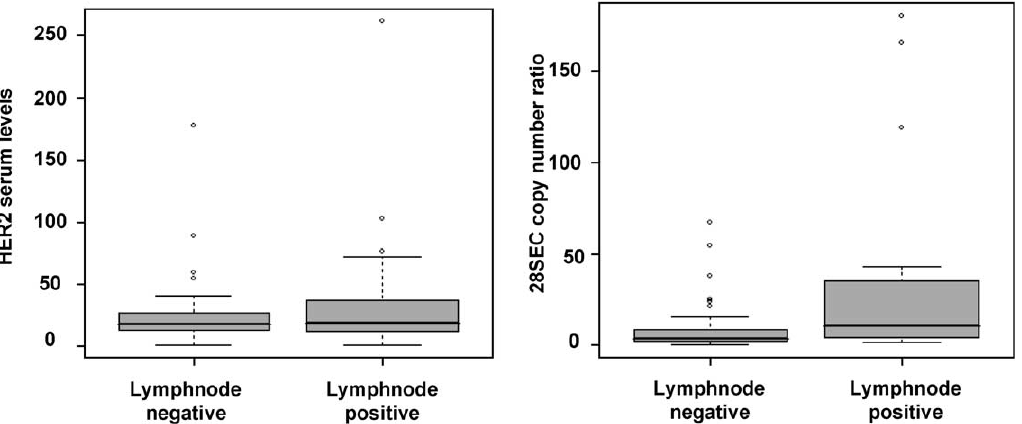
Fig. 4. Box plot for the HER2 serum concentrations determined by EIA and for the HER2/28SEC copy number ratios determined by QPCR in lymph node positive cases as compared with lymph node negative cases. The lines inside the boxes denote median values. The whiskers represent the interval between the 10th and 90th percentiles. The empty circle indicates the outliners values between 1.5 and 3 length upper or down from the interquartile range.